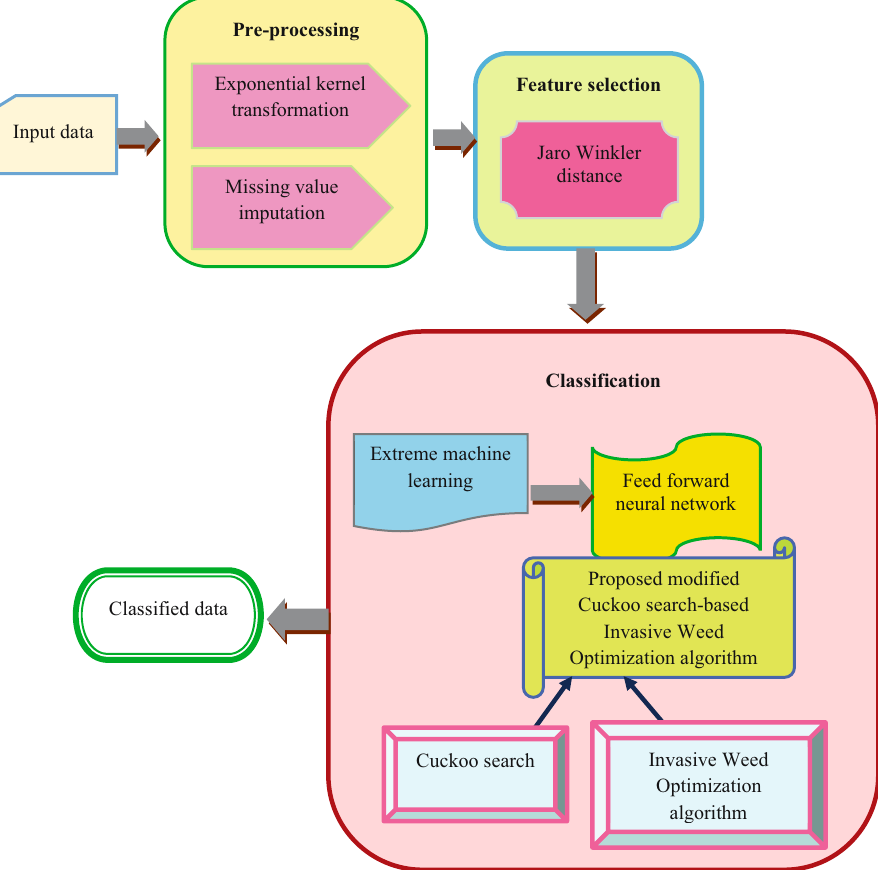
Figure 1: Architecture diagram of modi fi ed CSIWO ELM - based